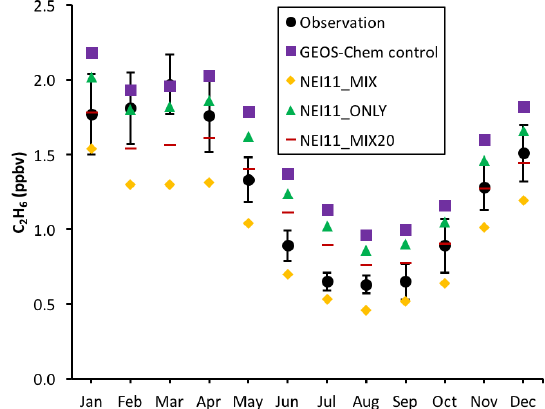
Figure 5. Monthly mean surface C 2 H 6 mixing ratios at Sum- mit from observations (black circles), GEOS-Chem model con- trol simulations (purple squares), NEI11_MIX (orange diamond), and NEI11_ONLY (green triangles) simulations during 2008–2010; vertical bars denote the standard deviation over the course of ob- servations for each month. NEI11_MIX represents model perturba- tions with global C 2 H 6 emission inventories overwritten by NEI11 over the US and by MIX over Asia, with other model configurations identical to the control simulations. NEI11_ONLY denotes the sim- ulation that is the same as the control simulation, except that the C 2 H 6 emission inventory over the US is overwritten by NEI11. NEI11_MIX20 is the simulation that is identical to NEI11_MIX except for the 20% increased MIX C 2 H 6 emission inventory over